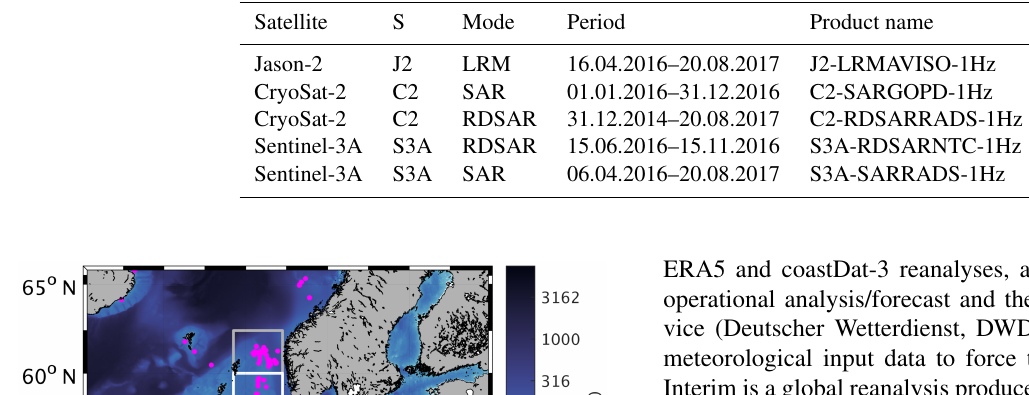
Table 1. Type and availability of the satellite data.